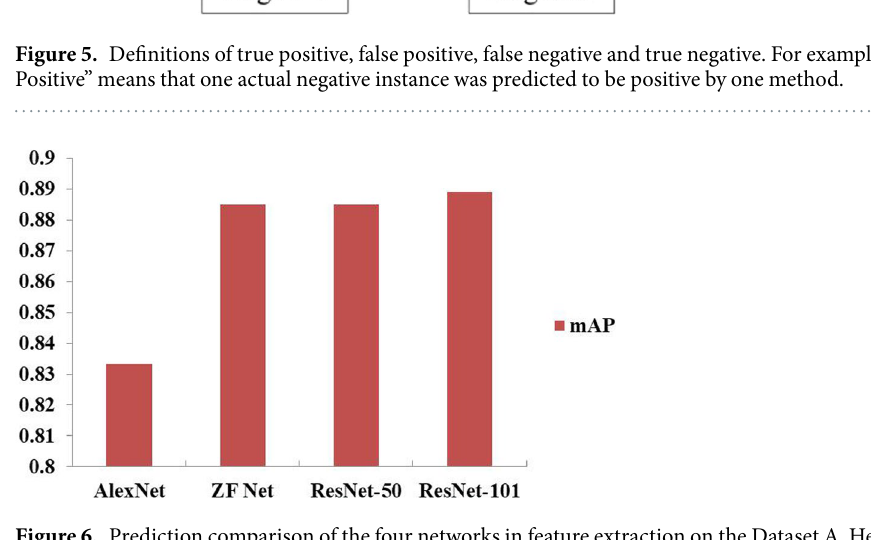
Figure 6. Prediction comparison of the four networks in feature extraction on the Dataset A. Here, ZF Net and ResNet performed better than